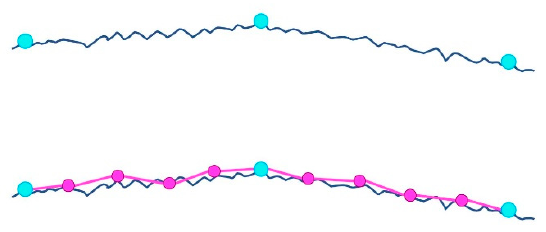
Figure 9. Example of the approximation method for the pavement surface.